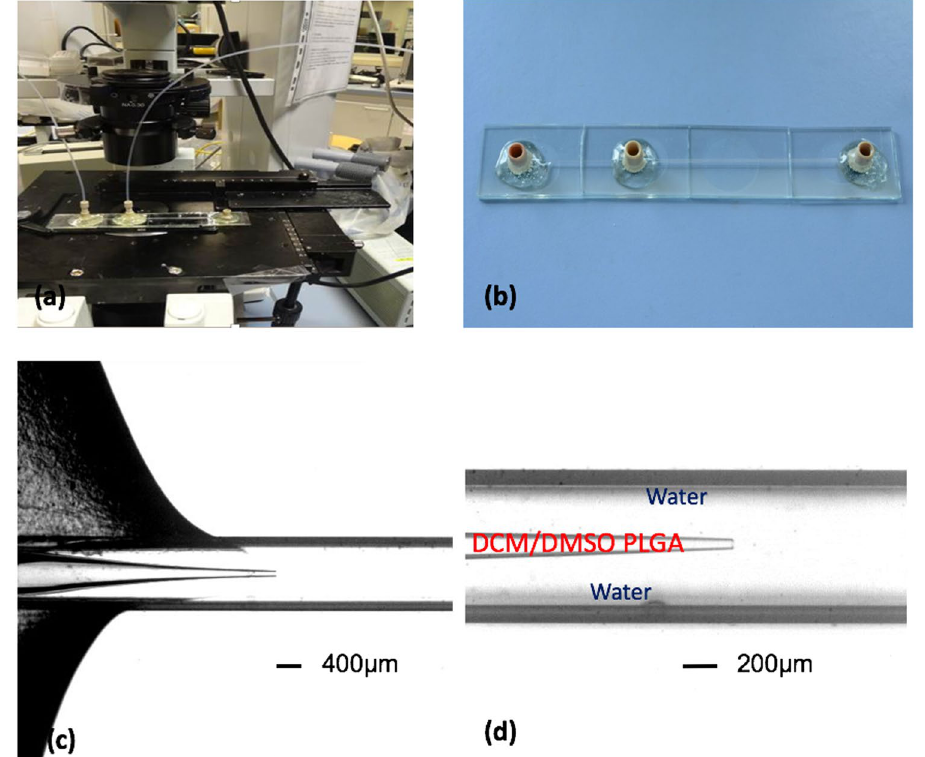
Figure 1. Coaxial microfluidic device fabricated with glass capillaries. ( a ) A microfluidic platform under operation; ( b ) A microfluidic chip constructed of glass capillaries and NanoPort assemblies (Upchurch Scientific); ( c ) The device under optical microscope; ( d ) The nozzle of the inside round capillary under optical microscope. The nanoparticles are formed away from the nozzle in the large capillary